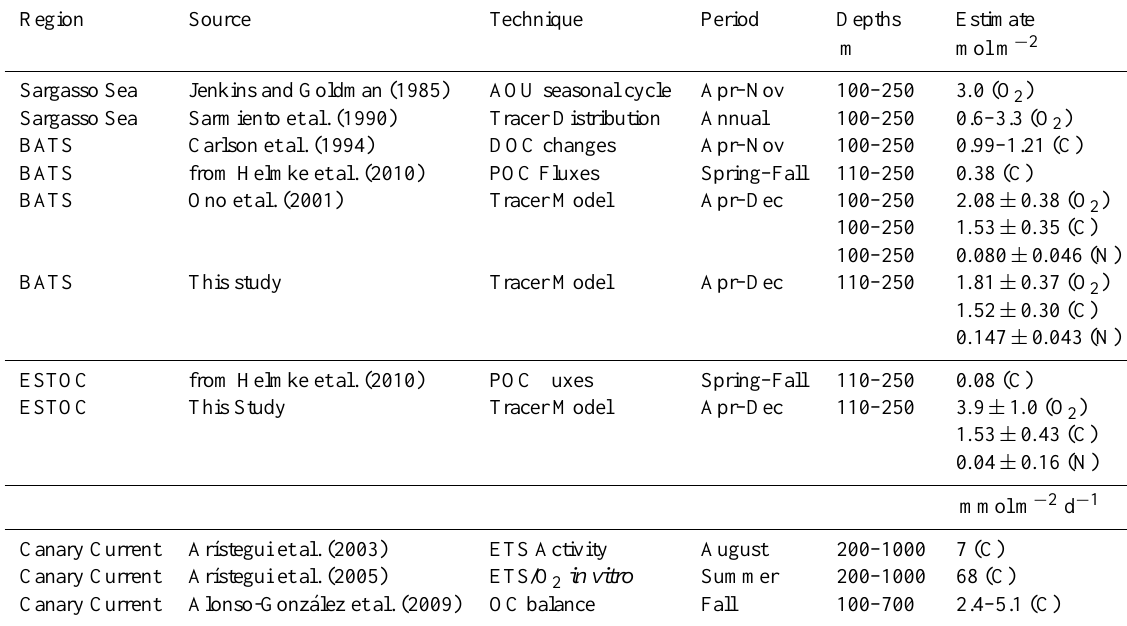
Table 2. Summary for remineralization estimates at BATS and ESTOC. AOU is apparent oxygen utilization; DOC, dissolved organic carbon; POC, particulate organic carbon; ETS, electron transport system and OC is organic